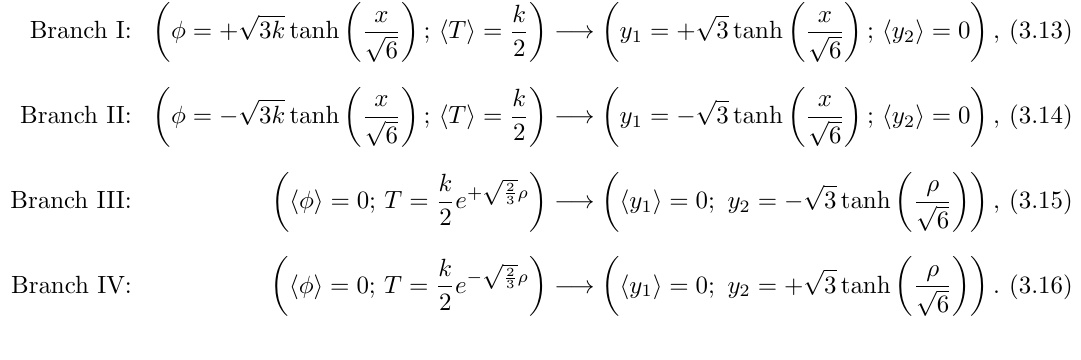
The expressions for the canonically (cid:12)eld rede(cid:12)nitions (3.7) and (3.9) in the ( y